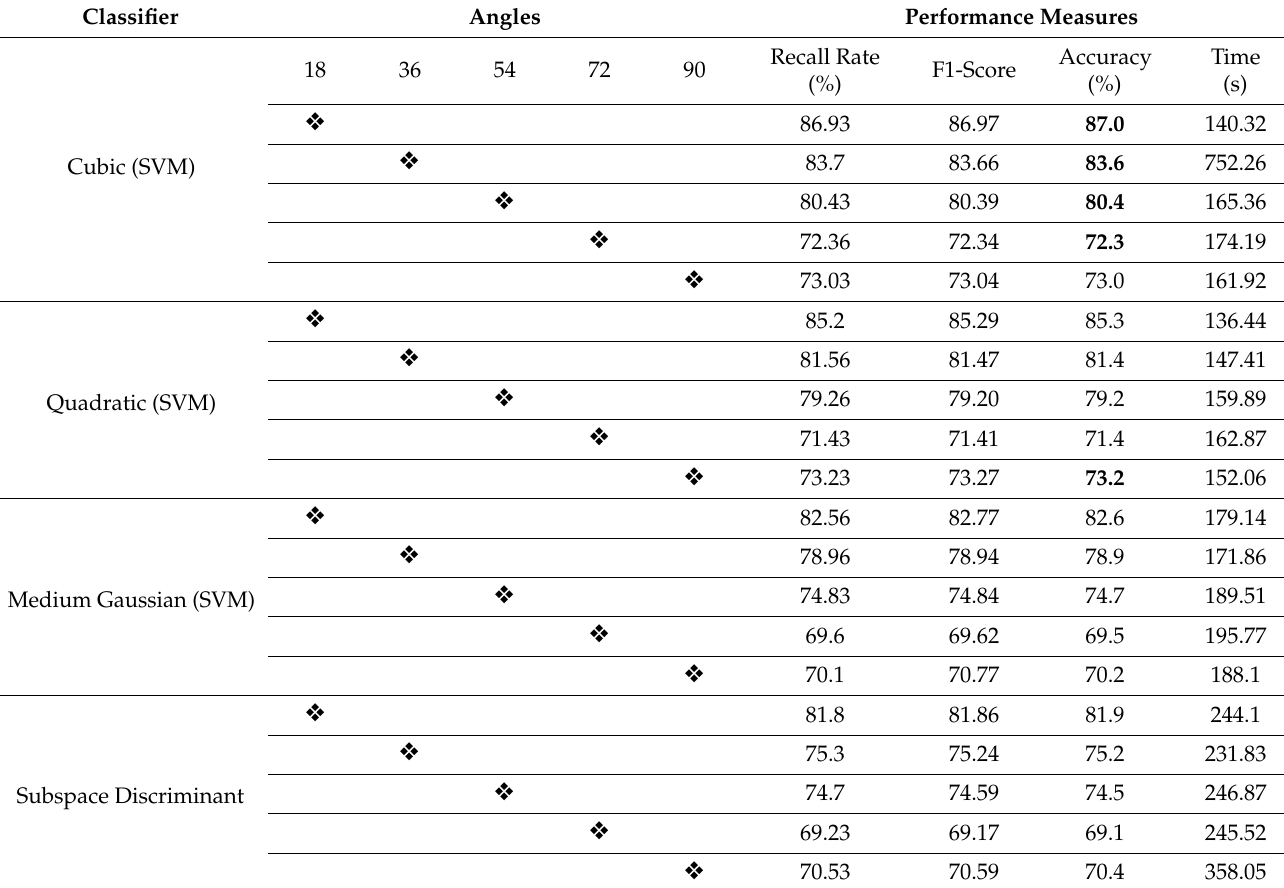
Table 3. Gait recognition results using modified NasNet-Mobile on selected angles of the non-augmented CASIA B da- taset.